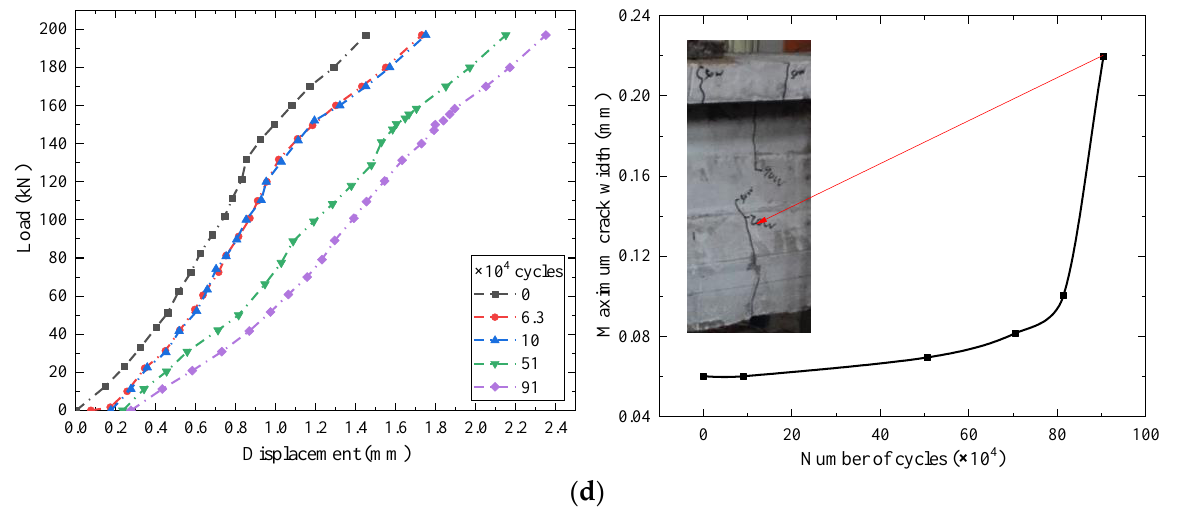
Figure 8. Development of the midspan displacement and main crack under fatigue loading: ( a ) The test beam C1; ( b ) The test beam C2; ( c ) The test beam C3; ( d ) The test beam C4.